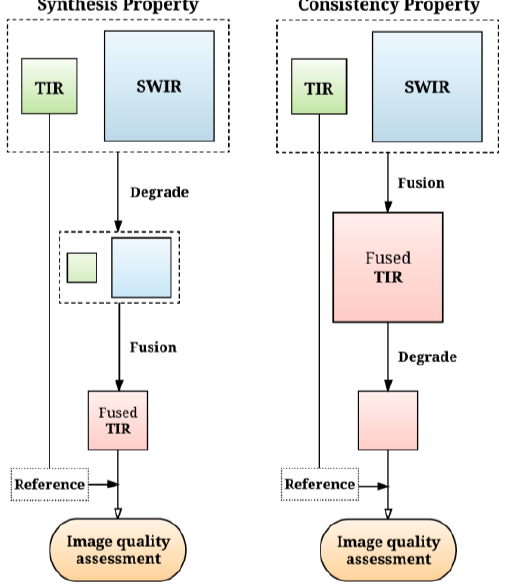
Figure 3. Overview of synthesis and consistency properties for evaluation of disaggregated image